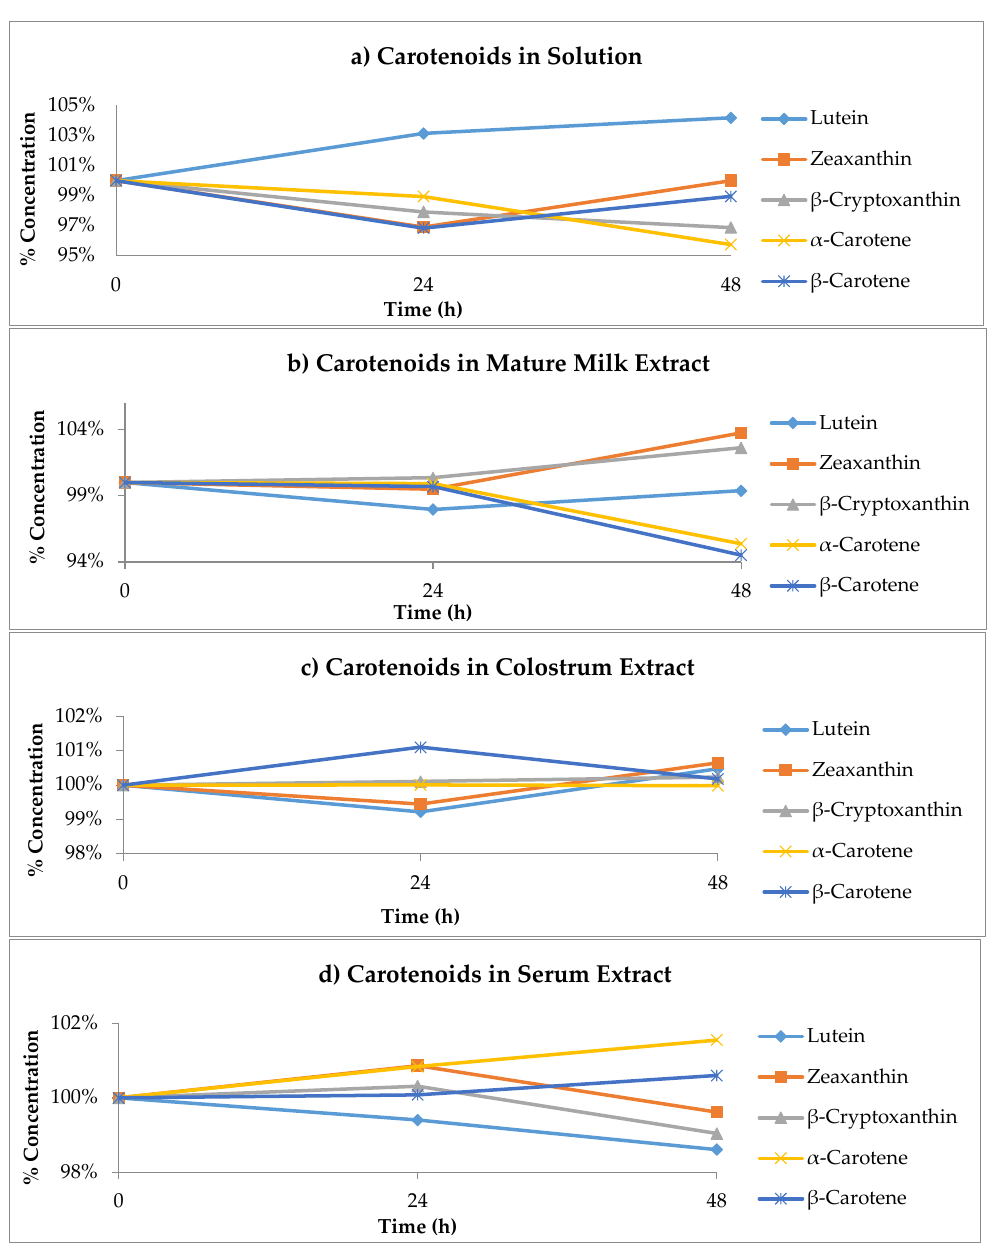
Figure 3. Stability of carotenoids in ( a ) solution (MTBE:Ethanol with BHT, 80:20, v / v ) and in different sample extracts ( b – d ) in an autosampler at 8 °C. Testing points at 0, 24, and 48 h. Y axis: Concentrations of carotenoids (normalized to percentage). X axis: Testing points.